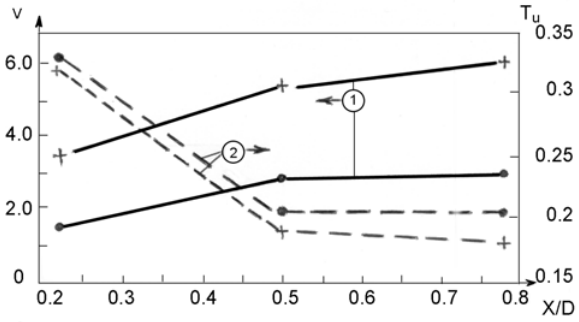
Рис. 10. Продольная составляющая скорости потока ( V ) и степени турбулентности потока в аэродинамиче- ском следе за блоком насадки ВПЯМ при разных чис- лах Re D (опыты А. Сакалаускаса): ● – Re D = 6 800; + – Re D = 15 600 Fig 10. Longitudinal component of velocity of stream ( V ) and degrees of turbulence of stream in aerodynamic environment behind the block of sedimentation high poro- sity material at different numbers Re D (A.Sakalauskas' experiments): ● – Re D = 6 800; + – Re D = 15 600